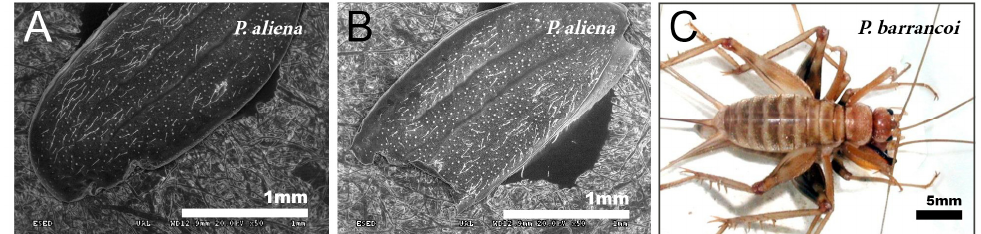
Figure 6. Devoured tegmina and copula in Petaloptila . SEM pictures showing incomplete tegmina in P. aliena , one more incipient ( A ) and the other with a higher degree ( B ). The image on the left ( C ) shows copulation in P. barrancoi in which the female stands on top of the male and the male flips the tegmina forward.